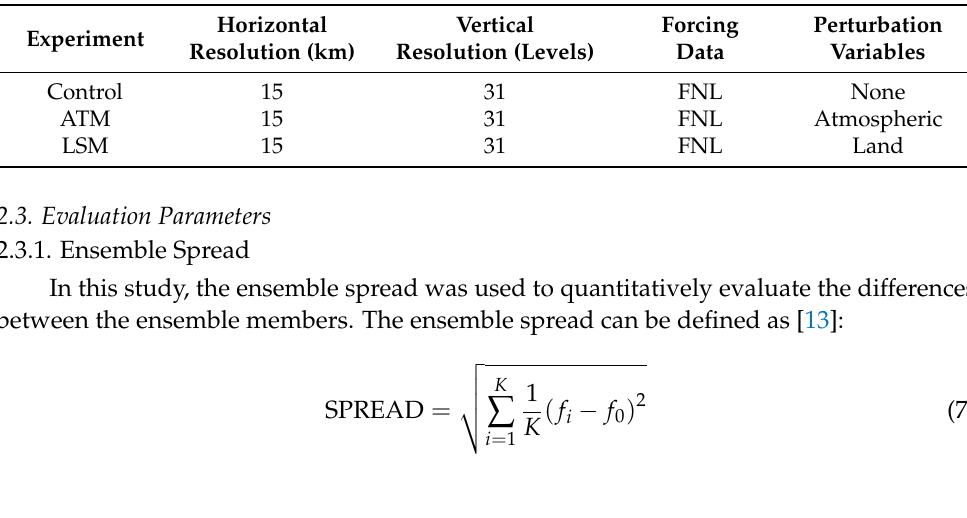
Figure 3. Schematic representation of the WRF forecast process for this study. Table 1. Designed ensemble subsets (ATM and LSM) as compared with the control